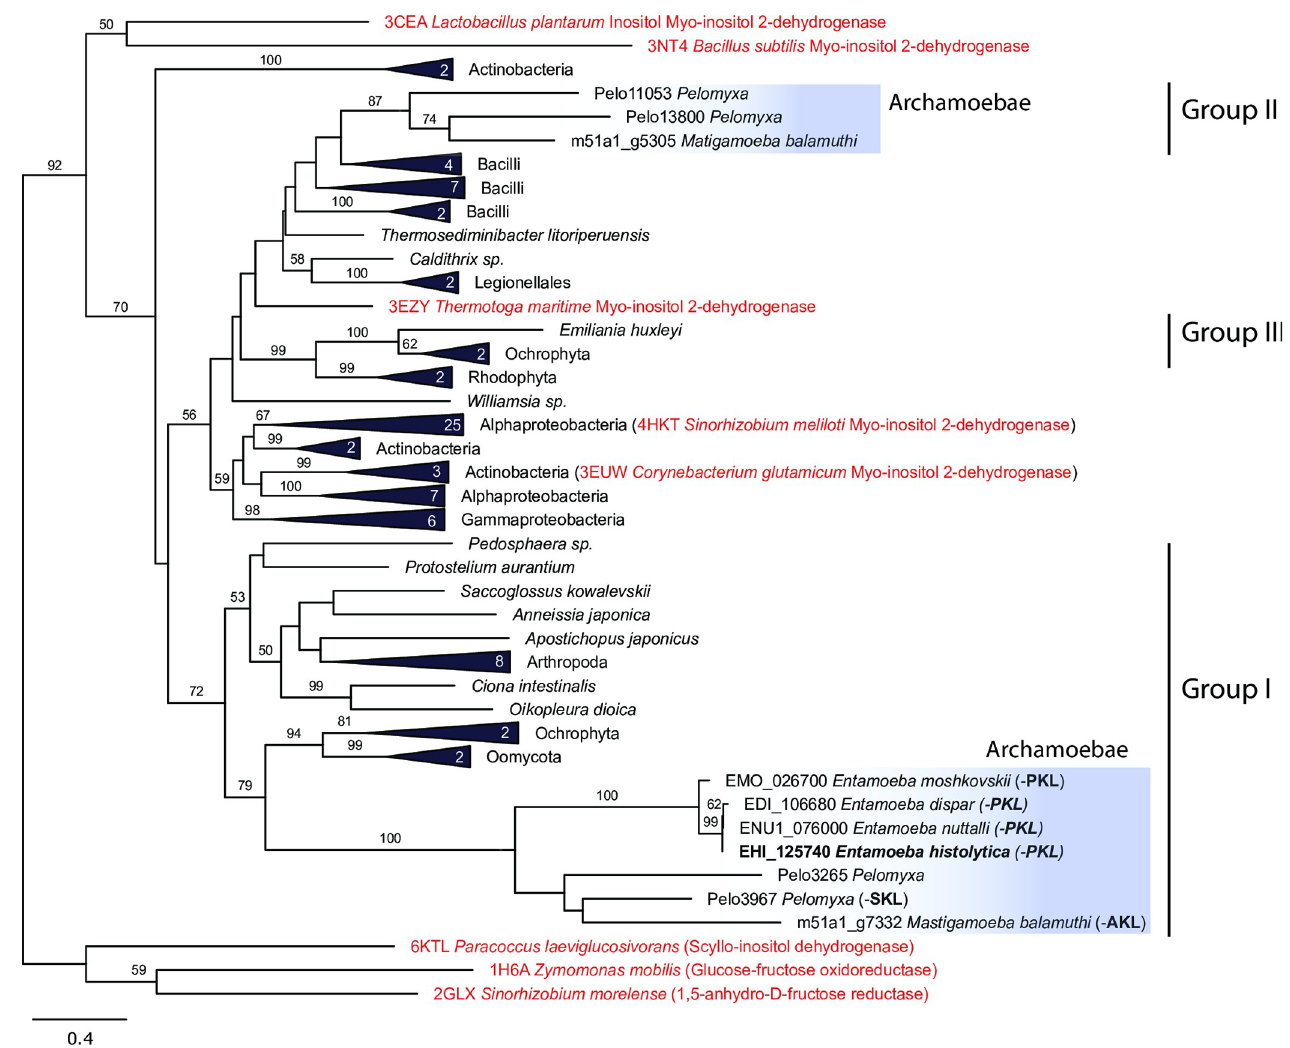
Fig 12. Phylogeny of myo -IDH. The maximum likelihood tree was inferred with IQ-TREE using 103 protein sequences and 289 positions. Bootstrap support is given at nodes. Sequences with known crystal structures are highlighted in red. Numbers in triangles indicate the number of included sequences. PTS1 triplet is given in